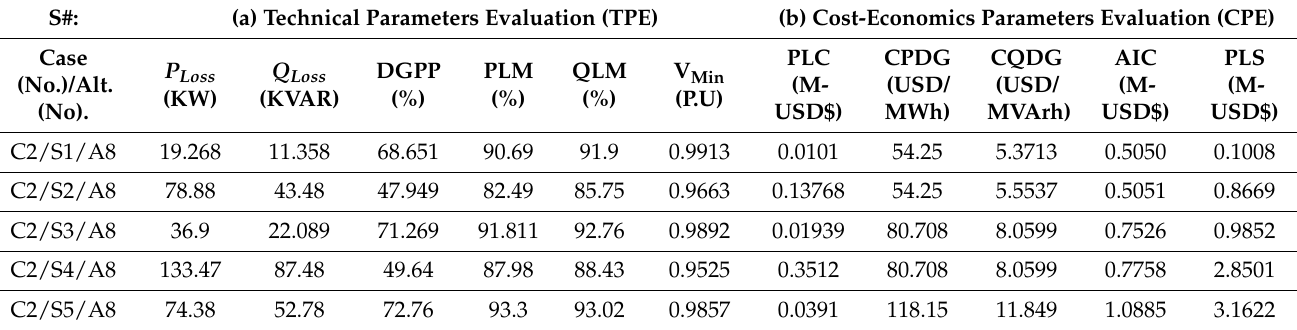
Table 12. Environment-socio (EPE/SPE) evaluations in C2/S1–S5 for the 33-bus MDN.